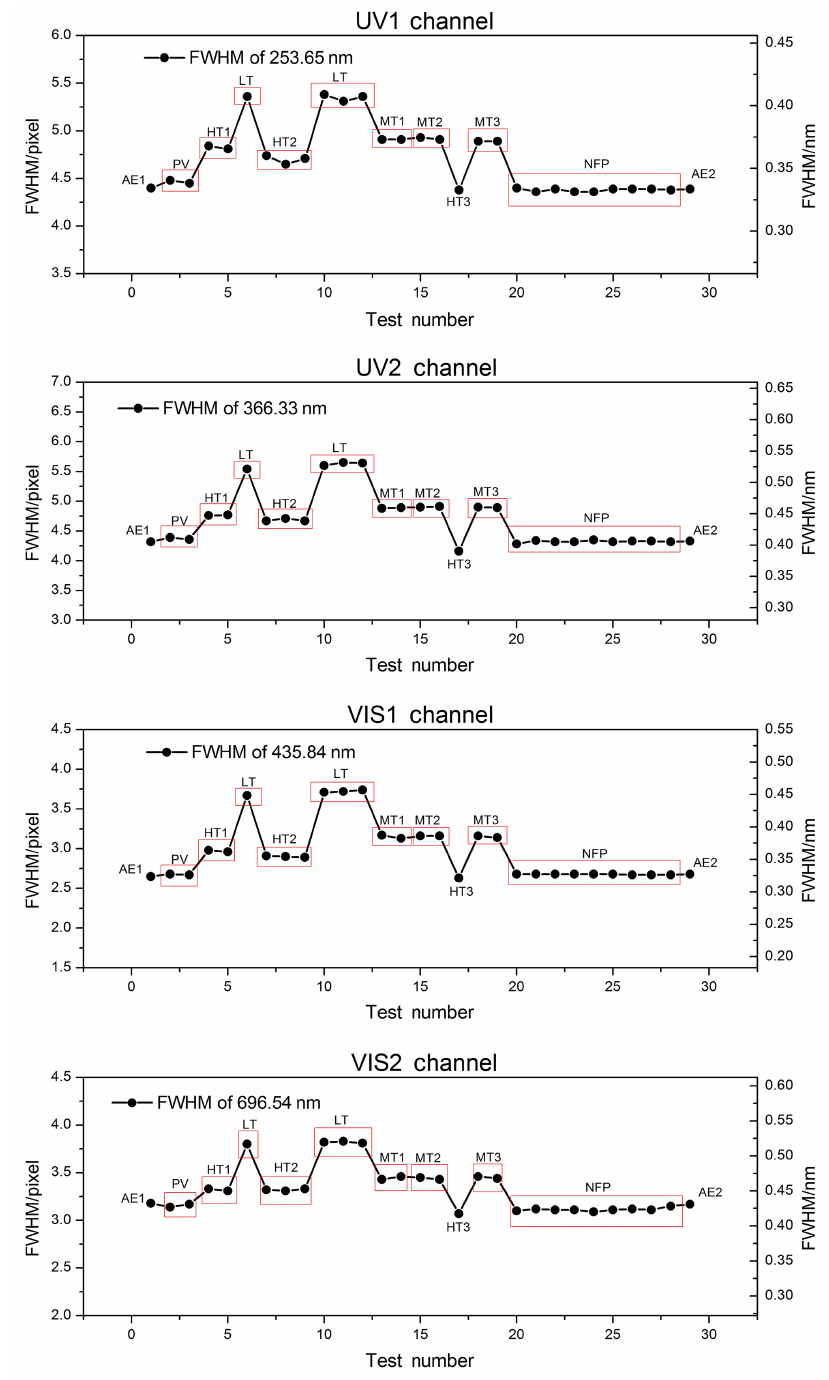
Figure 6. Results of the thermal vacuum test on the FWHM of the ILS. The results show that (1) the FWHM of the ILS is essentially the same in different pressures in the thermal vacuum chamber (see AE, PV, and NFP results) and that (2) the FWHM of the ILS shrinks with the increase in the optical bench temperature under a vacuum